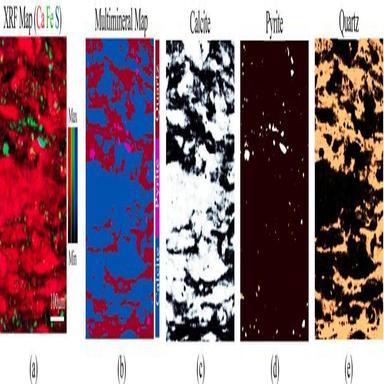
Eagle Ford shale (a) three-element XRF map of the EFS1 area (0.25 mm2 ) indicating calcium, iron and sulfur intensities; (b) a multimineral map of the three primary minerals, calcite, pyrite and quartz, with a 2 μm resolution, and; (c–e) single mineral maps for each mineral where black represents no presence in all three maps.